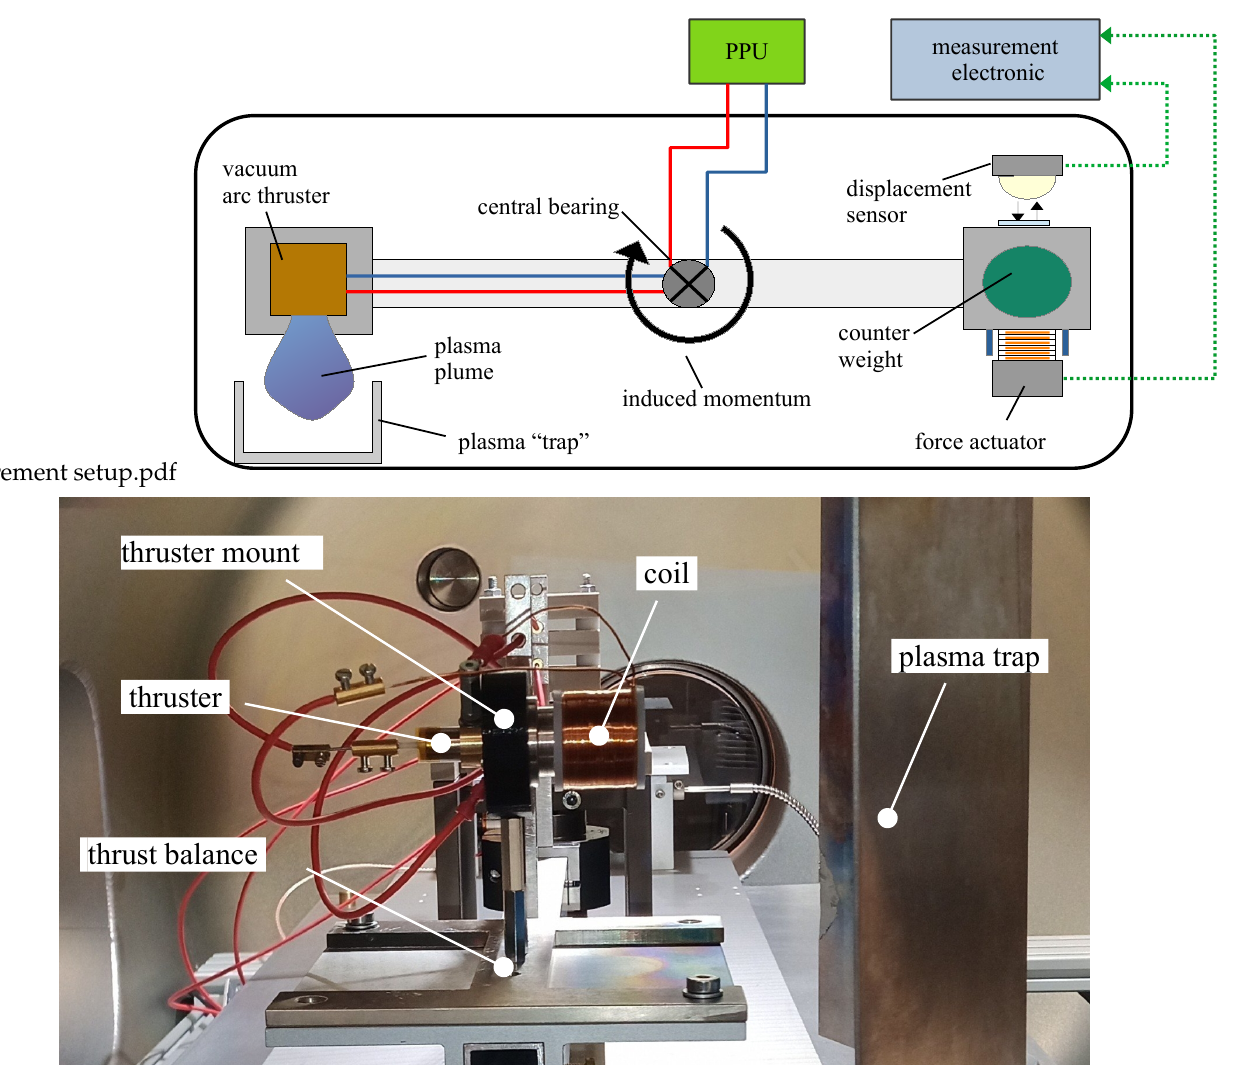
Figure 4. Schematic top view ( top ) and photographic side view ( bottom ) of the thrust balance setup inside the vacuum facility. The detailed connections to the PPU are not